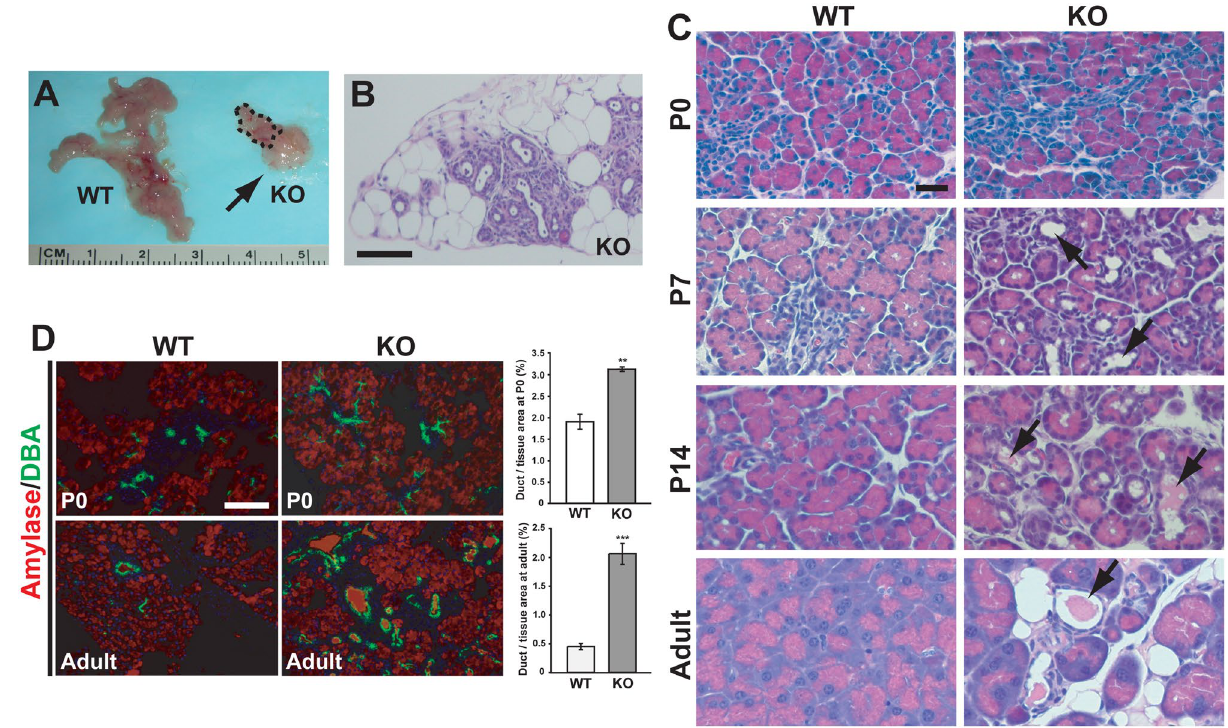
Figure 1. Progressive exocrine pancreatic degeneration in Cby1-KO mice after birth. ( A ) Gross morphology of adult pancreata. The Cby1-KO pancreatic tissue is encircled by a dotted line. The arrow denotes ectopic adipose mass in the Cby1-KO pancreas. ( B ) H&E staining of the adult Cby1-KO pancreas with extensive lipomatosis. Scale bar, 200 μm. ( C ) Pancreatic sections of WT and Cby1-KO mice at the indicated ages were stained with H&E. Arrows indicate dilated ducts. Scale bar, 20 μm. ( D ) Ductal expansion in the pancreas of Cby1-KO mice. Pancreatic sections of P0 and adult mice were stained with DBA-lectin (ductal cell marker, green) and α-amylase antibody (acinar cell marker, red). Mean ratios of ductal to total tissue areas ± SEM are shown on the right. For each group, three individual animals were used for IF staining, and five non-overlapping fields per animal were photographed for quantification. Scale bar, 50 μm. **p < 0.01; ***p <